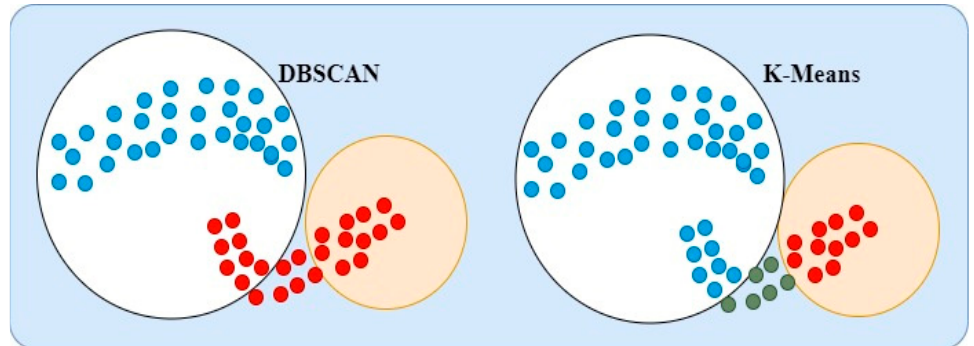
Figure 16. The difference between density-based clustering and partition-based clustering methods.